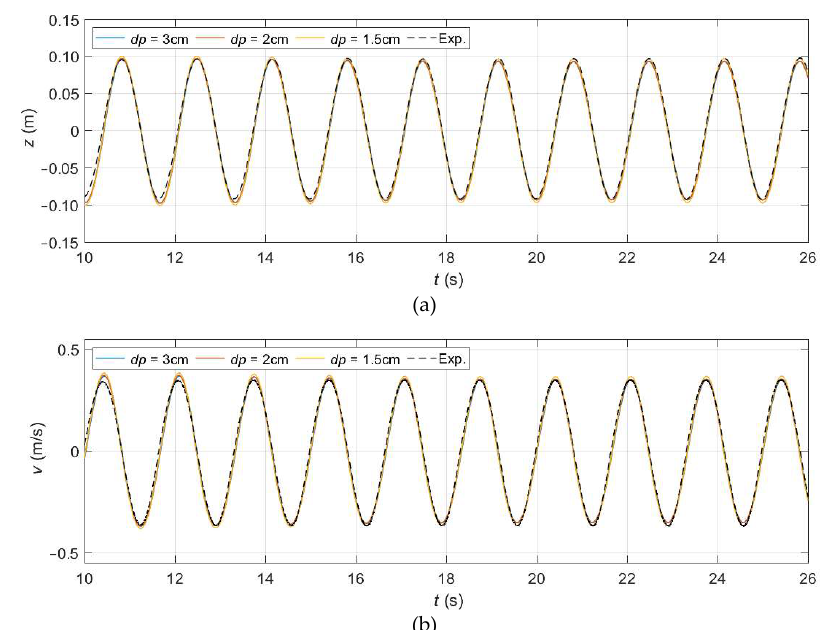
Figure 5. Numerical and experimental time series of the heave position ( a ) and velocity ( b ) for three values of dp .